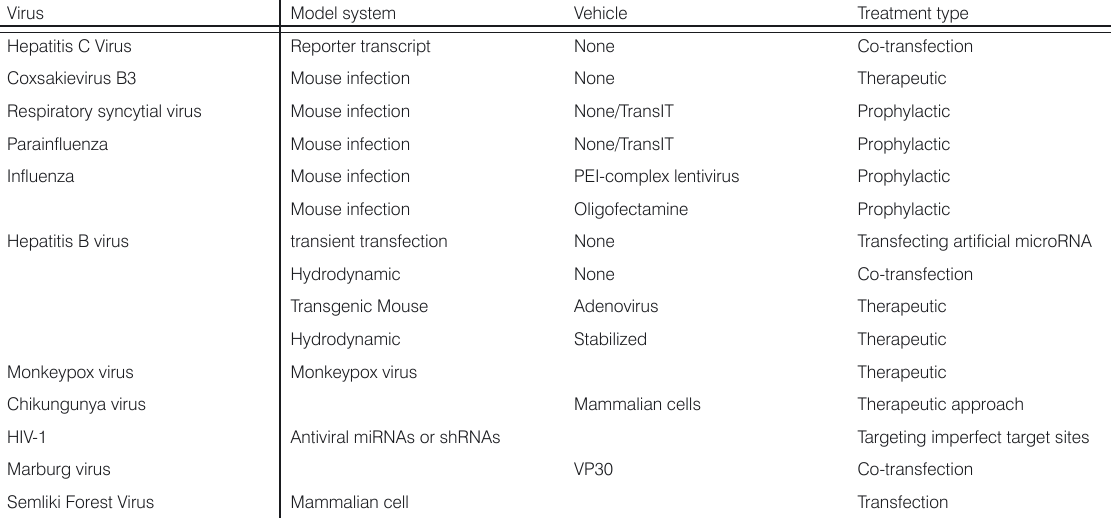
Table 1. Inhibition of viral gene expression by RNAi-mediated